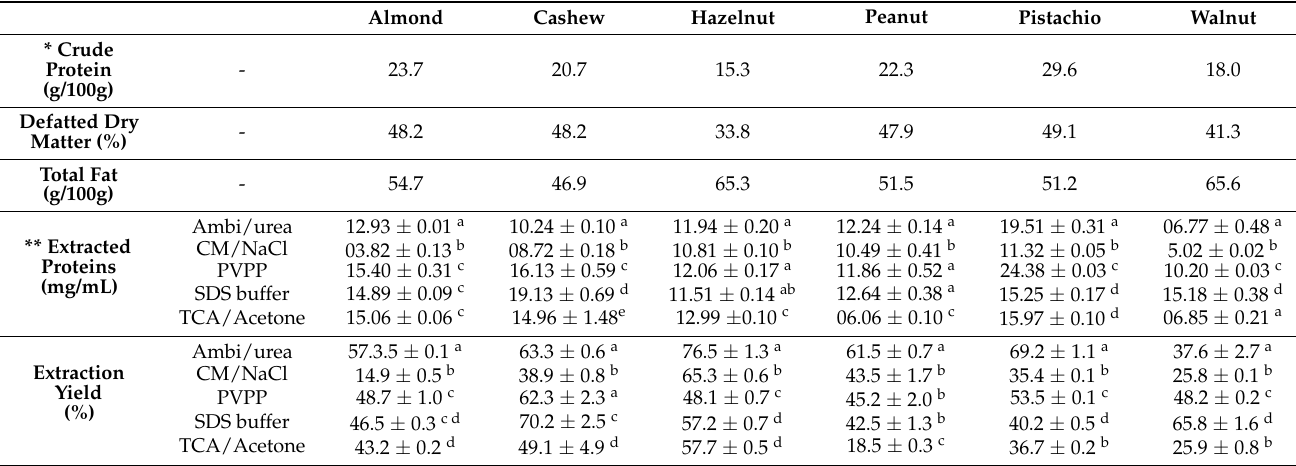
* Total protein content according to Kjeldahl. ** Extracted protein according to Bradford and expressed as mg protein/mg defatted nut flours. Means with different lowercase letters in the same column indicate significant differences at p = 0.05 (Tukey test); n =